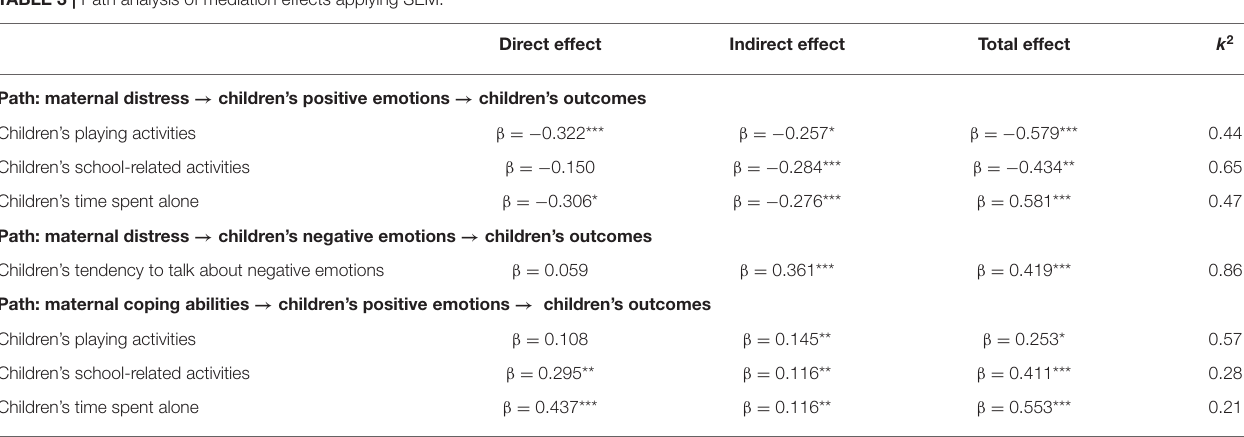
TABLE 3 | Path analysis of mediation effects applying